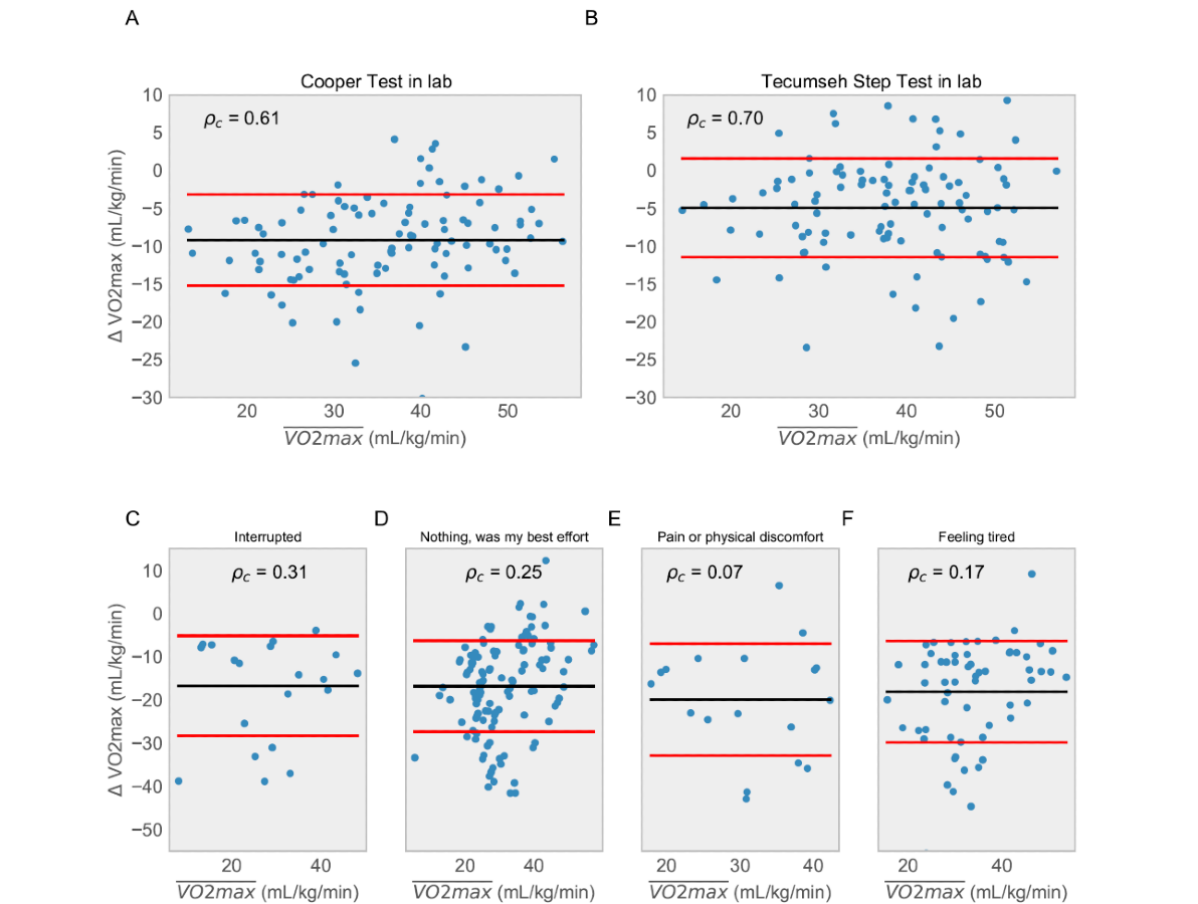
Figure 2. Comparison of in-clinic performance of silver standard protocols relative to the gold standard for (A) 12-minute run test (12-MRT) and (B) 3-minute step test. For each plot, we are showing the difference between the ground truth maximal oxygen consumption measurement and measurements obtained using the distance run around a track (for A) and heart rate via radial pulse measured by trained research staff (for B) as per Tecumseh protocol. This distance was also measured using GPS and heart rate was measured using a chest strap and Fitbit. The concordance between distance measured around the track and measured using the GPS in the phone was 0.96. (C) to (F) show the concordance of the 12-MRT test for different values of self-reported effort. VO 2 max: maximal oxygen